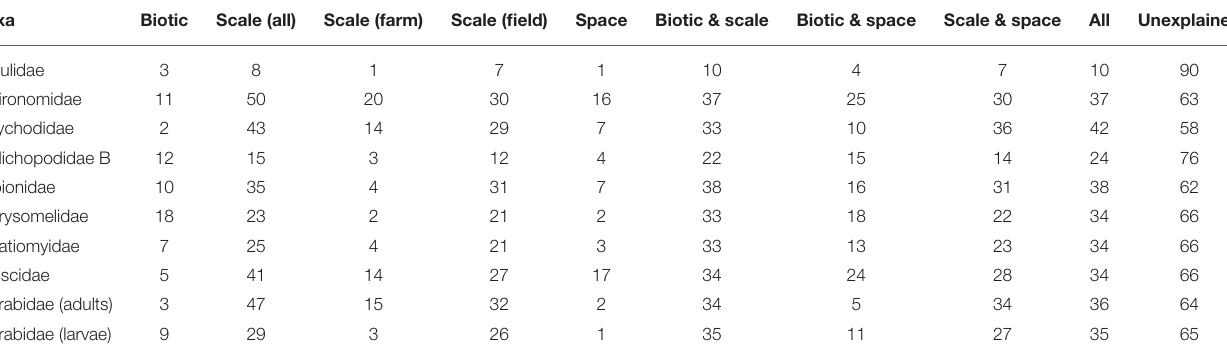
TABLE 4 | The percentage of deviance explained by a GLM with binomial distribution through partitioning the dependent variable (species presence/absence, for taxa with ≥ 5 individuals) between three groups of explanatory variables (biotic, scale and space), alone and in combination, and the deviance unexplained by the variables in this study for each taxa in